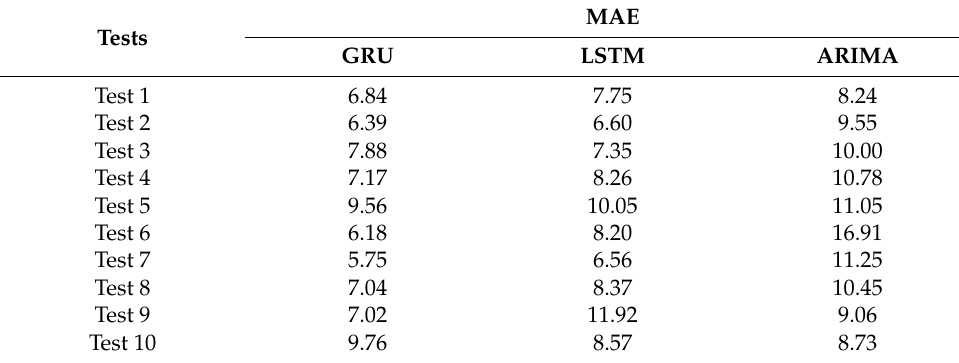
Table 3. Prediction performance comparisons in regular